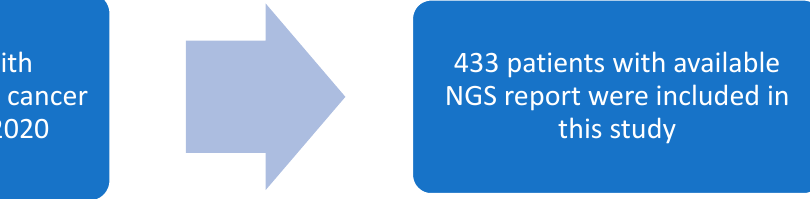
Figure 1. 626 patients with colorecal cancer was identified between 2013–2020. 433 of them had NGS report availabe therefore were eligible for this